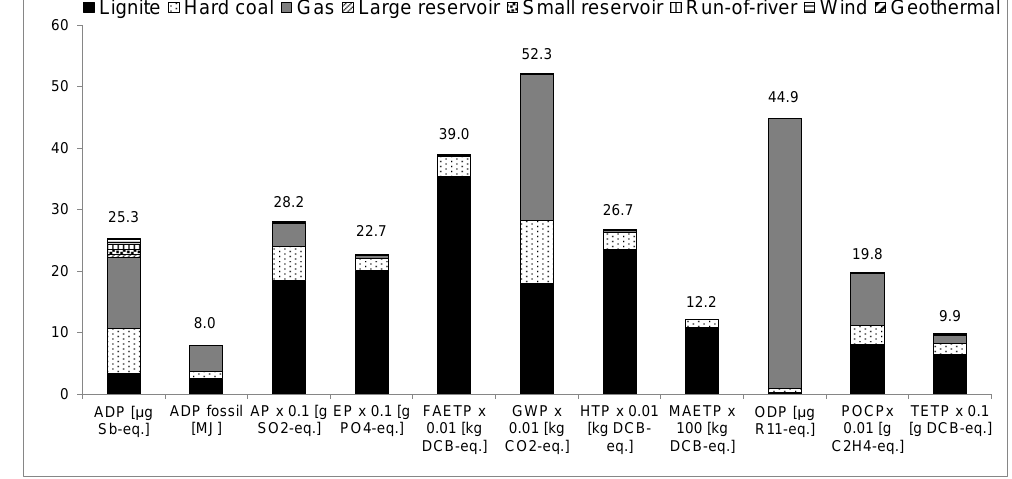
Figure 6. Environmental impacts per kWh of electricity for the base year (2010). [For impacts nomenclature, see Figure 3.].